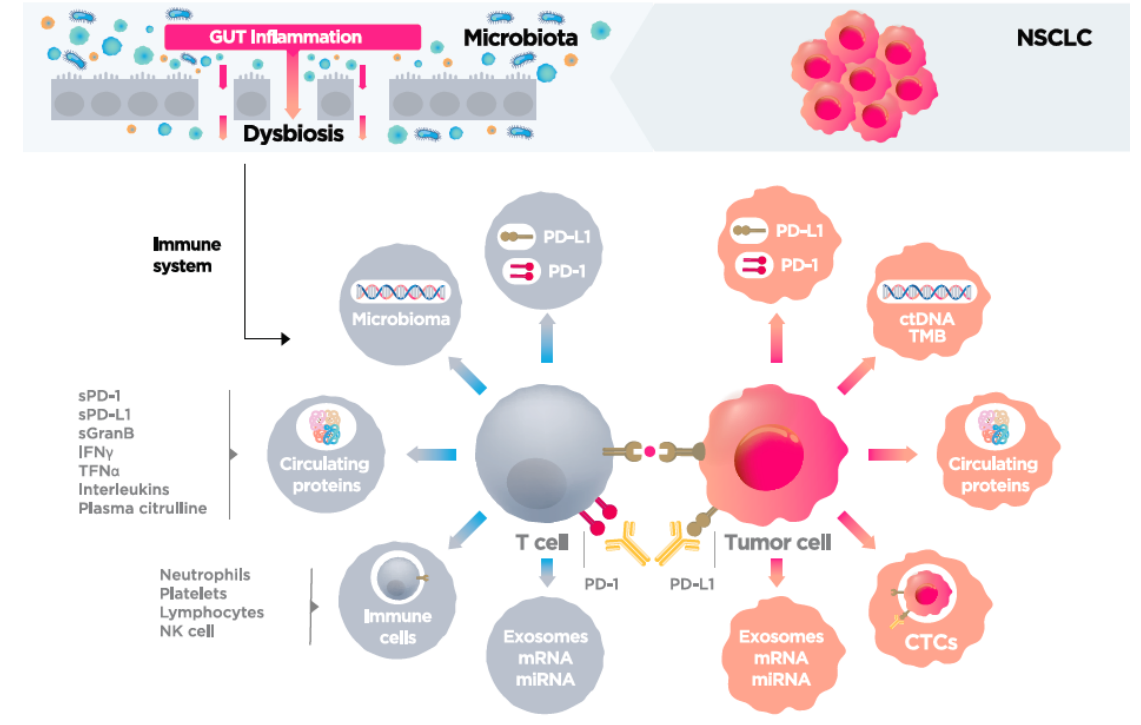
Figure 1. Soluble biomarkers of immune system response to immune therapy.